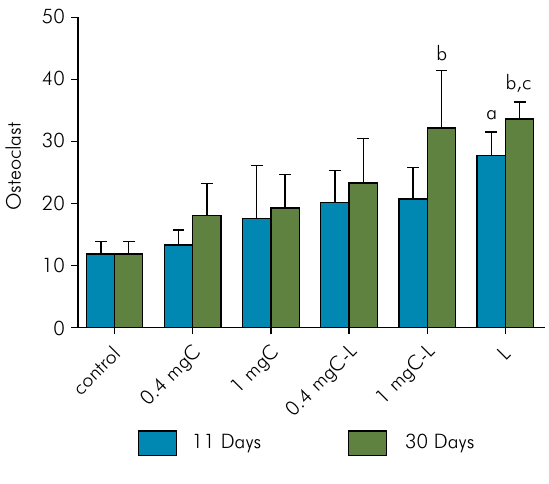
Figure 4. TRAP + osteoclast numbers in experimental groups and controls (mean ± SD).